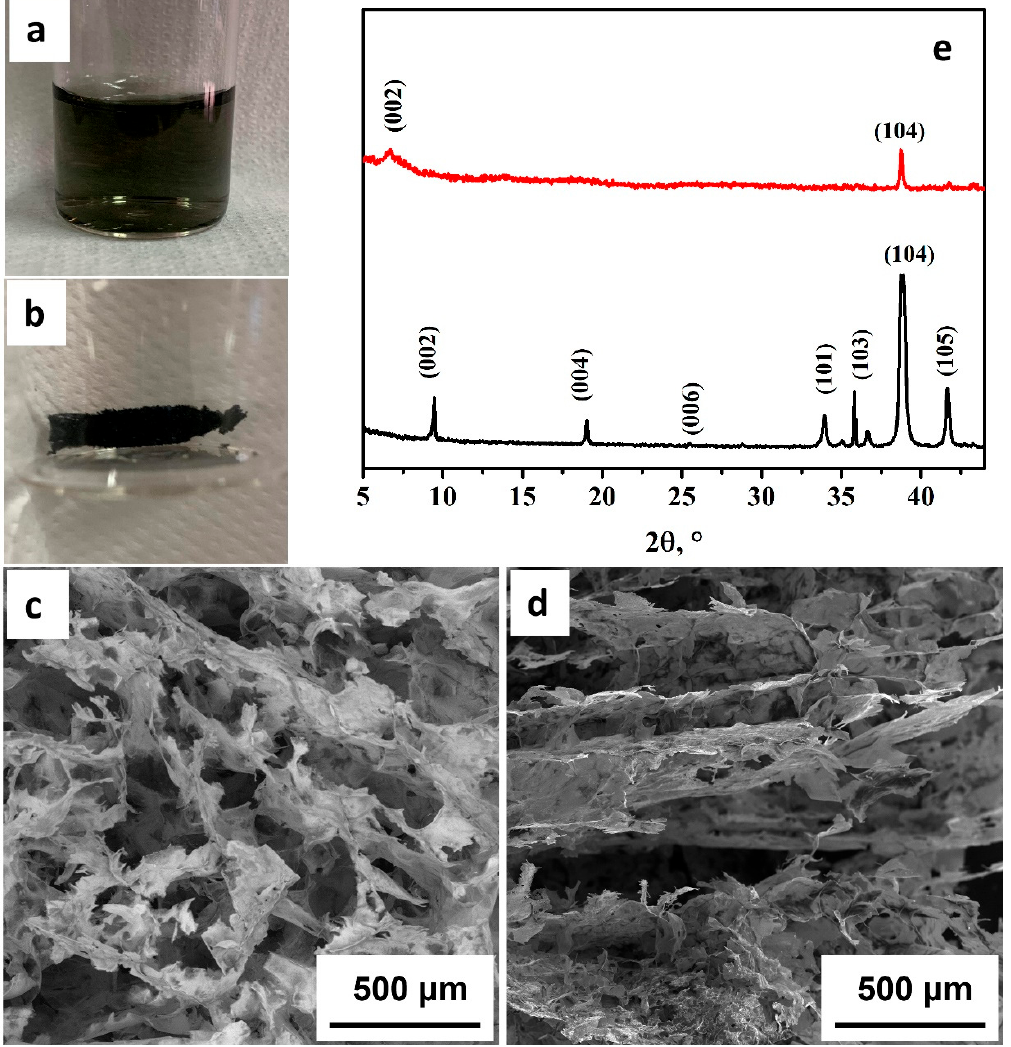
Figure 1. MXene morphology. ( a ) Dilution of the supernatant obtained in the MXene synthesis; ( b ) sponge obtained after the lyophilization process used in SEM analysis; ( c ) SEM image of the sponge observed crosswise; ( d ) SEM image of the longitudinal sample; ( e ) X-ray diffraction patterns of Ti 3 AlC 2 (black) and Ti 3 C 2 T x (red).